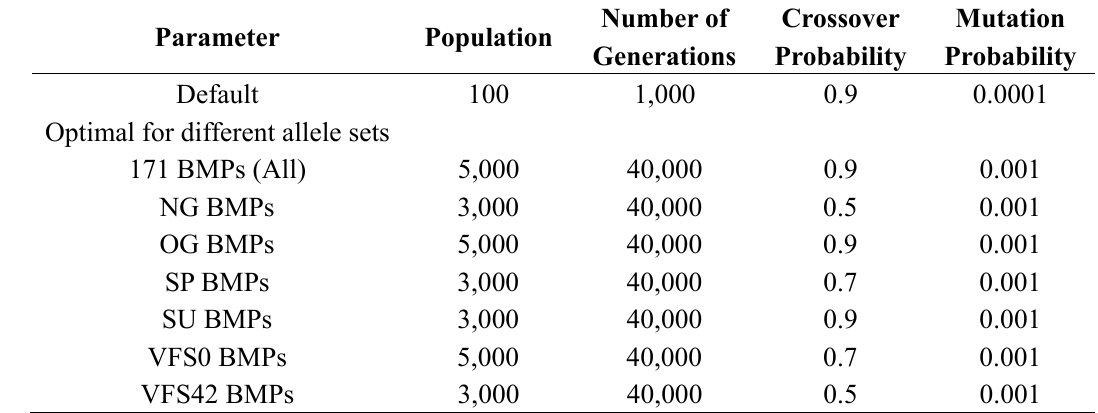
Table 1. Default and optimal GA parameters for different allele sets selected from sensitivity